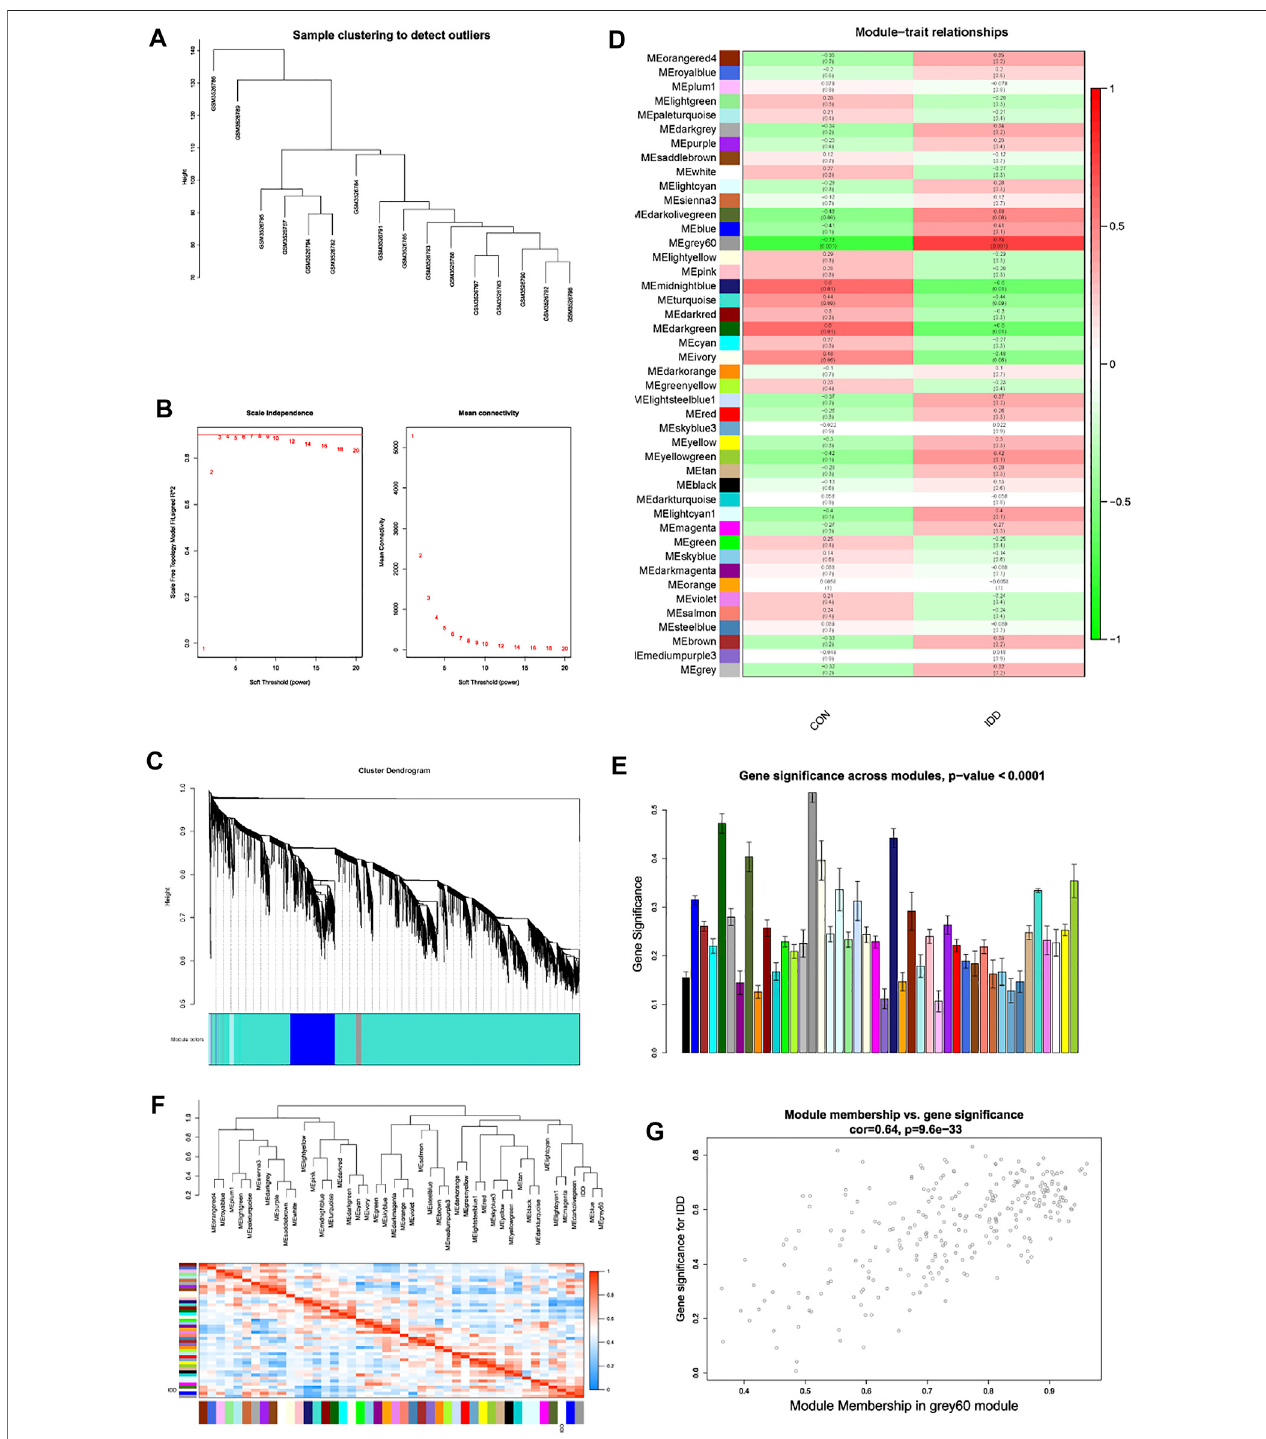
FIGURE4 | Weight gene co-expression networkanalysis. (A) sample clustering detection. (B) evaluation ofsoft threshold power, left panel represented scale-free fi t index, and right panel represented mean connectivity of these values. (C) clusteringdendrogram ofall genes based on dissimilaritymeasure (1-TOM) and assignment modules, and highly interacted genes were clustered together. (D) module-trait relationships between different modules and feature. (E) histogram of gene signi fi cance across modules in IDD group. (F) cluster dendrogram and heatmap of adjacency in the eigengene network. (G) scatter plot showing correlations of gene signi fi cance for IDD vs. module membership in grey60